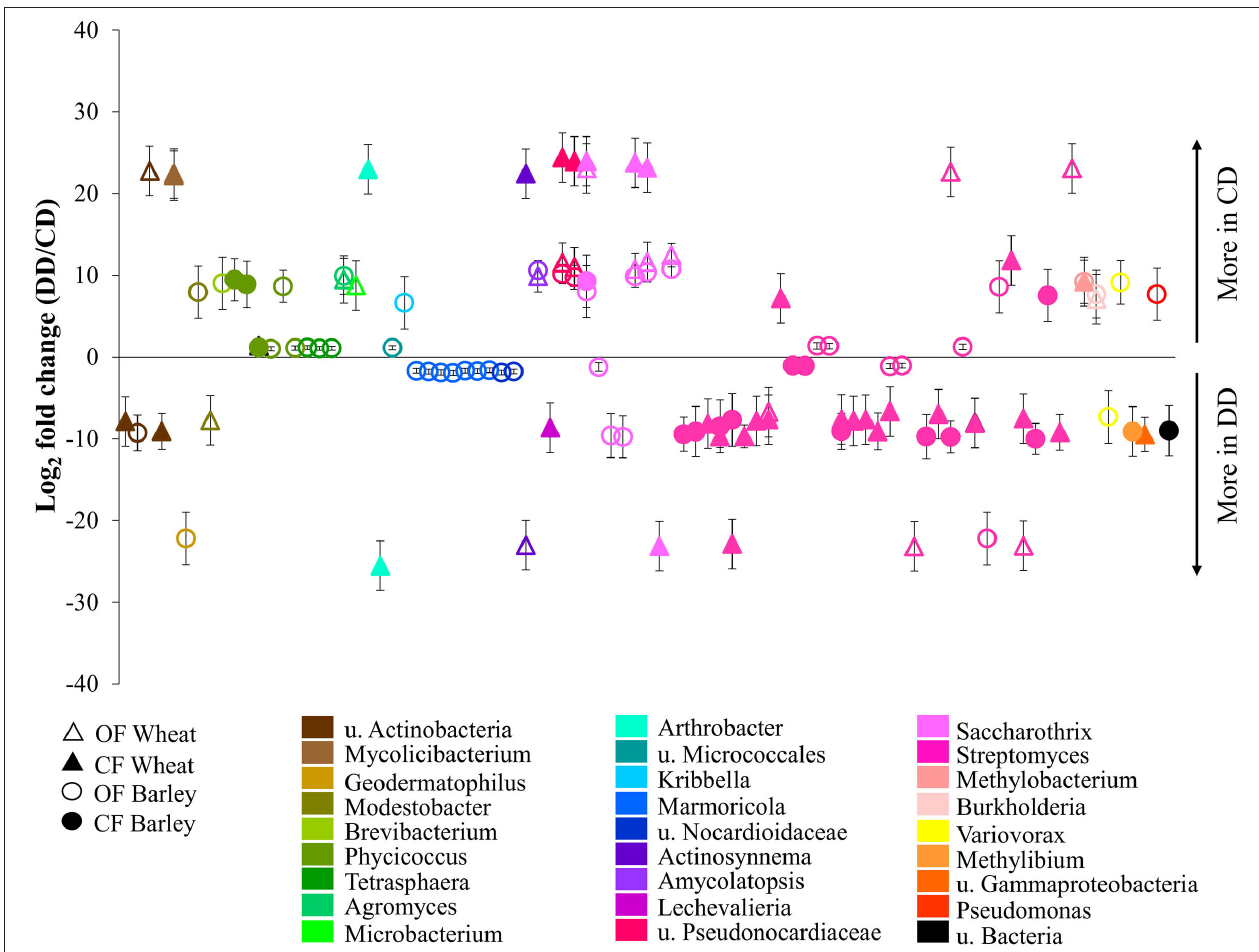
FIGURE 6 | Relative abundances of the acdS + ASVs significantly impacted by drought conditioning. Taxa were identified using DESeq2 and P -value < 0.05, and log2-fold changes between respective treatments are represented. CF, conventional farming; OF, organic farming; CD, “single water deficit,” control and dry conditions; DD, “water deficit history,” dry conditions and dry conditions; n = 5